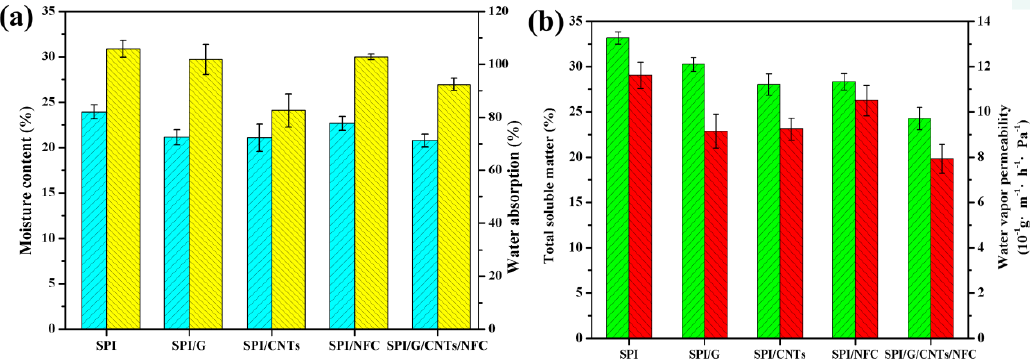
Figure 10. ( a ) Moisture content (MC) and water absorption (WA), ( b ) total soluble matter (TSM) and